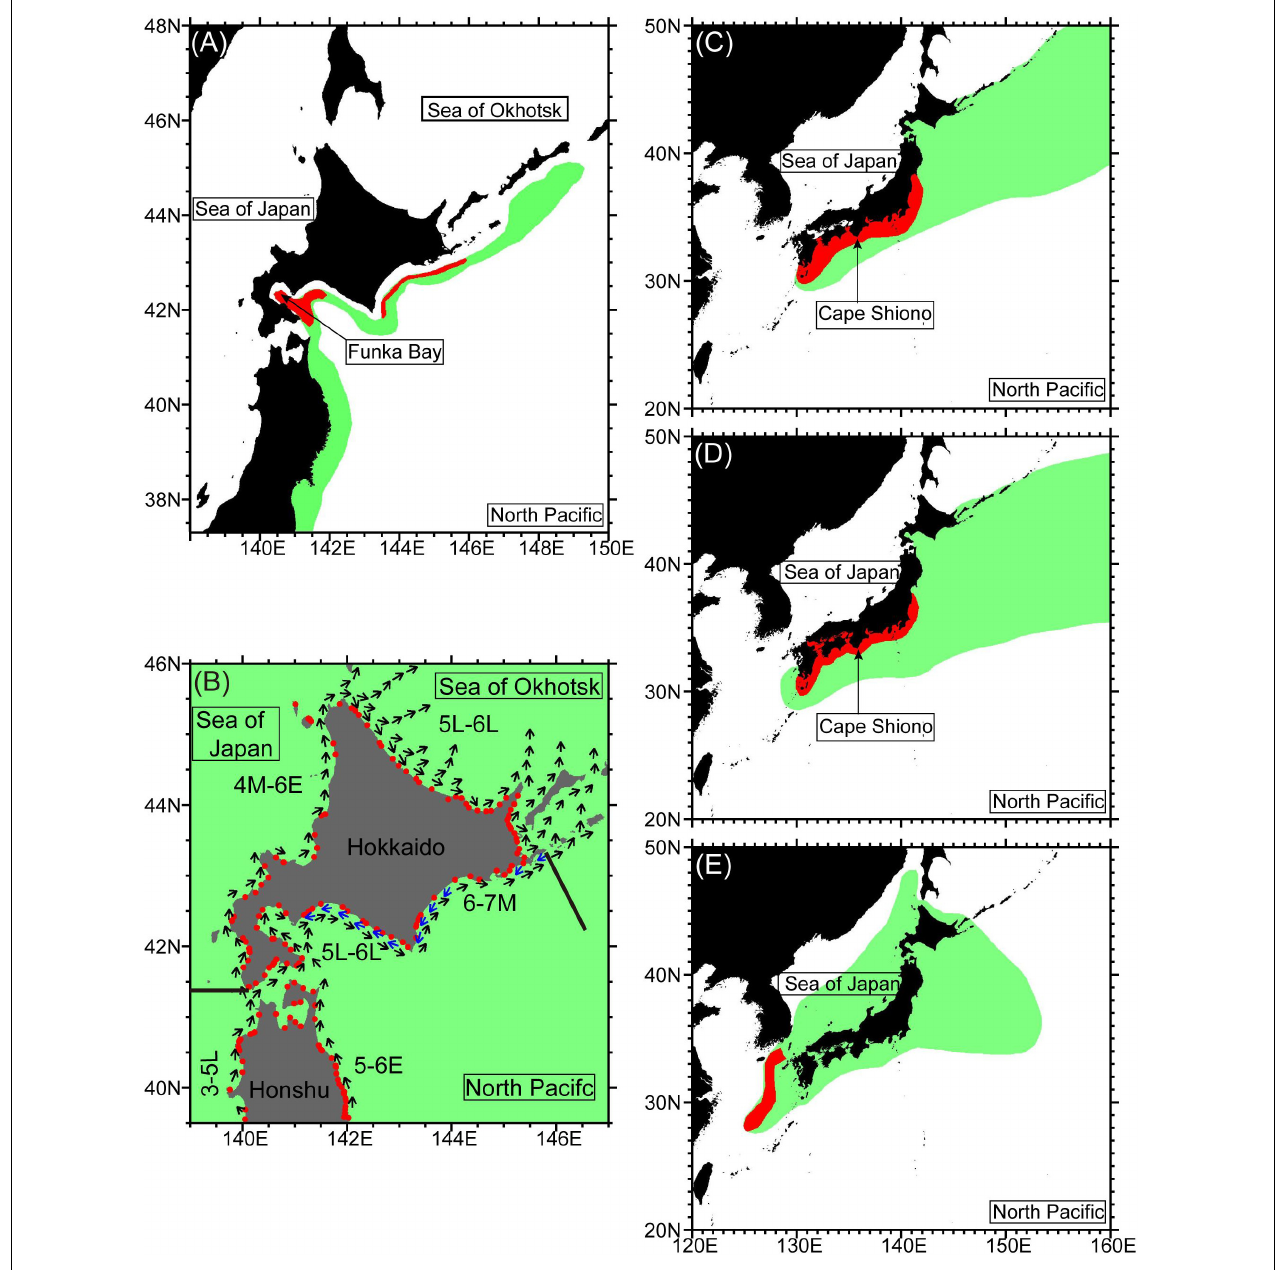
FIGURE 6 | Spawning area (red shading) and distribution area (green shading) of (A) the Japanese Pacific stock (JPS) of walleye pollock, (B) Japanese chum salmon, (C) Pacific stock of Japanese sardine, (D) Pacific stock of Japanese anchovy, and (E) winter spawning stock of Japanese flying squid. Panel (A) is digitized from Sakai et al. (2019), (B) is from Urawa et al. (2018), (C,D) are from Oozeki et al. (2019), and (E) is from Kaga et al. (2019). Red circles in (B) indicate the mouths of rivers where data for chum salmon are registered in the Salmon Database (Saito et al., 2015). Juvenile chum salmon from Honshu and Hokkaido migrate near the coast in the direction of the vectors in (B) during the early (E), middle (M), or late (L) part of the months, indicated by numerals. Solid lines in (B) denote the westernmost and easternmost boundaries of Pacific waters along the Hokkaido coast, which are used in Figure 8B .